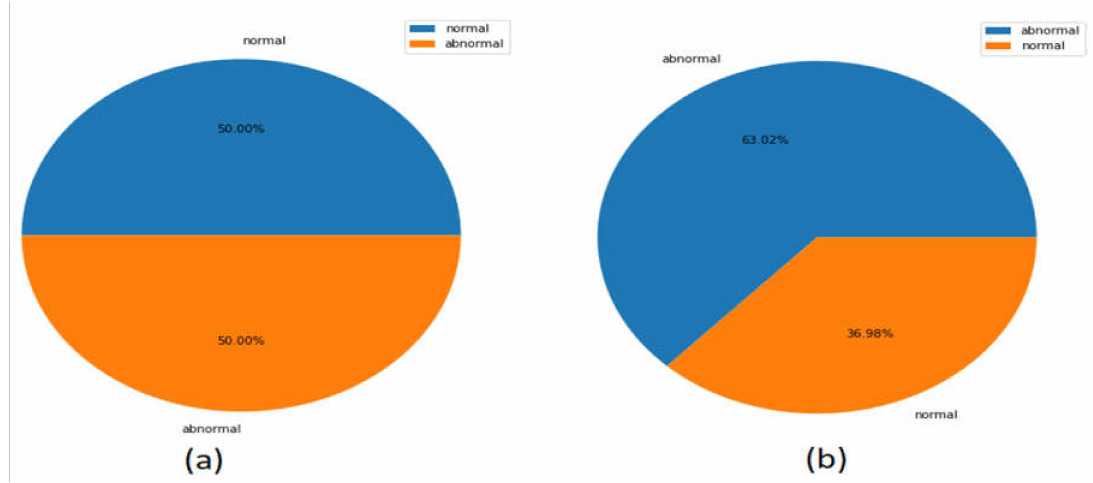
Figure 4. Percentage of classes of the datasets ( a ) CICAndMal2017 and ( b )